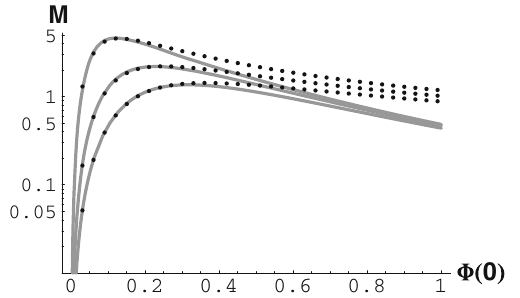
Fig. 4 Approximatechargedbosonstarmass M (includingtheelectric √ (cid:14)/( Gm ) as a function of (cid:15)( 0 ) = energy) in units of g = 0 . 1 , 0 . 2 , and 0 . 3 (from the upper line to the lower line) for the case (cid:14) → ∞ . The dots indicate the numerical results in the large coupling